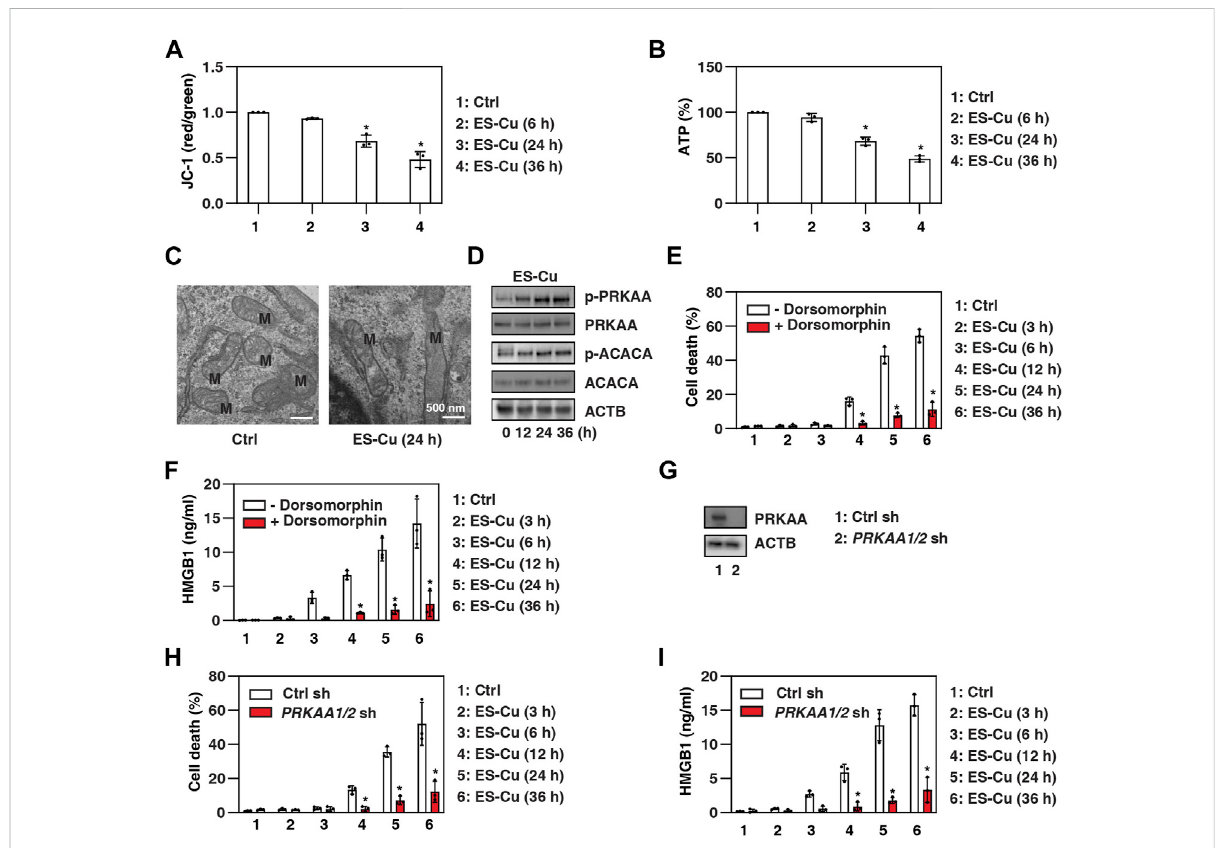
FIGURE 2 AMPK inhibits HMGB1 release during cuproptosis. (A – D) Analysis of mitochondrial membrane potential (JC-1 staining), intracellular ATP, mitochondrial ultrastructure (M = mitochondria), and protein expressions in Calu1 cells after treatment with ES-Cu (30 nM/30 nM) for the indicated times. (E,F) Calu1 cells were treated with ES-Cu (30 nM/30 nM) in the absence or presence of dorsomorphin (2 µM) for 3 – 36 h and then cell death and HMGB1 release were assayed (n = 3; * p < 0.05 versus control group, one-way ANOVA). (G) Western blot analysis of PRKAA expression in PRKAA1/2 -knockdown Calu1 cells. (H,I) Wild-type and PRKAA1/2 -knockdown Calu1 cells were treated with ES-Cu (30 nM/30 nM) for 3 – 36 h and then cell death and HMGB1 release were assayed ( n = 3; * p < 0.05 versus control group, one-way ANOVA). The results in (A – I) are representative of those from three independent